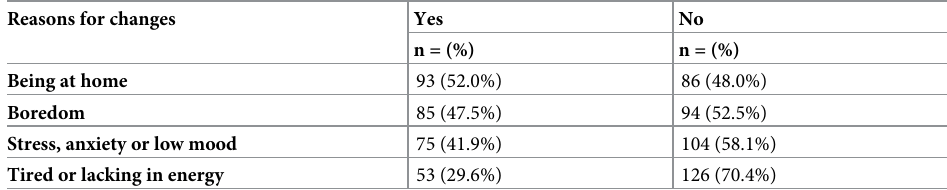
Table 3. Reasons given for increased food consumption.